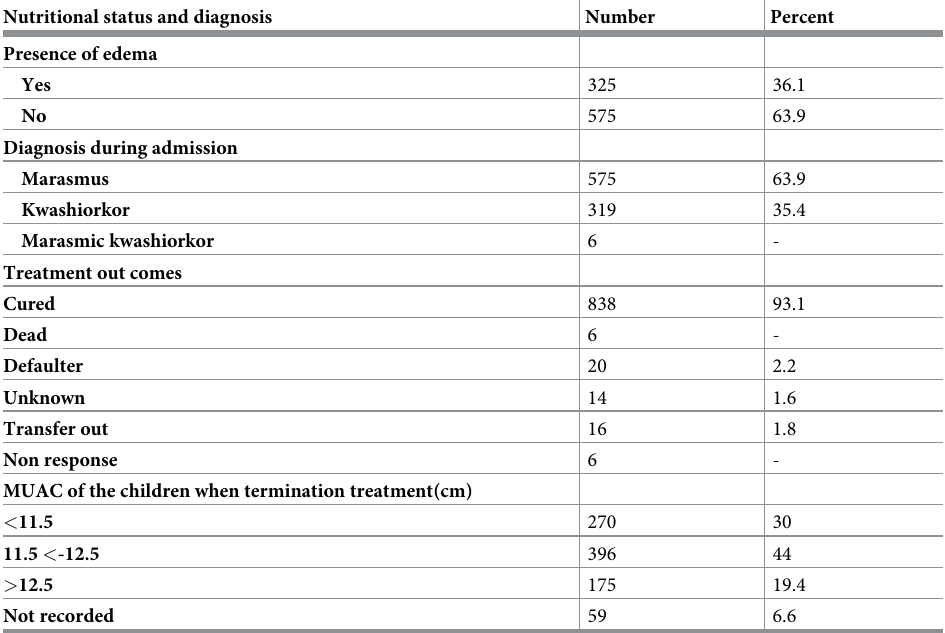
Table 2. Nutritional status of the children during admission among severe acute under nourished under five chil- dren in Hadiya Zone, SNNPR, Ethiopia in the las five years from 2014/2015-2019/2020 (n = 900).